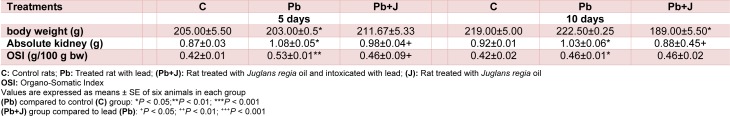
Body, kidney weights of adult rats treated with Pb and/or Juglans regia oil for 5 and 10 days